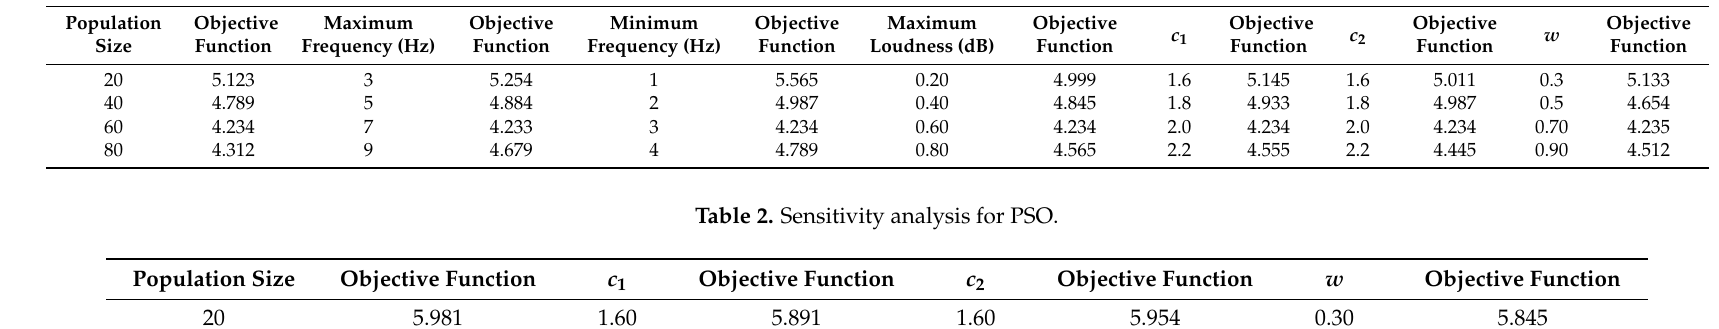
Table 1. Sensitivity analysis for hybrid algorithm.